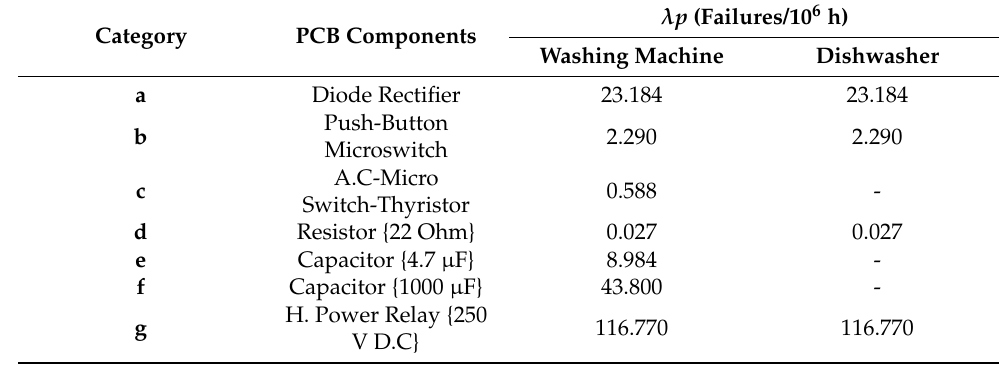
Table 6. Failure rate values for PCB